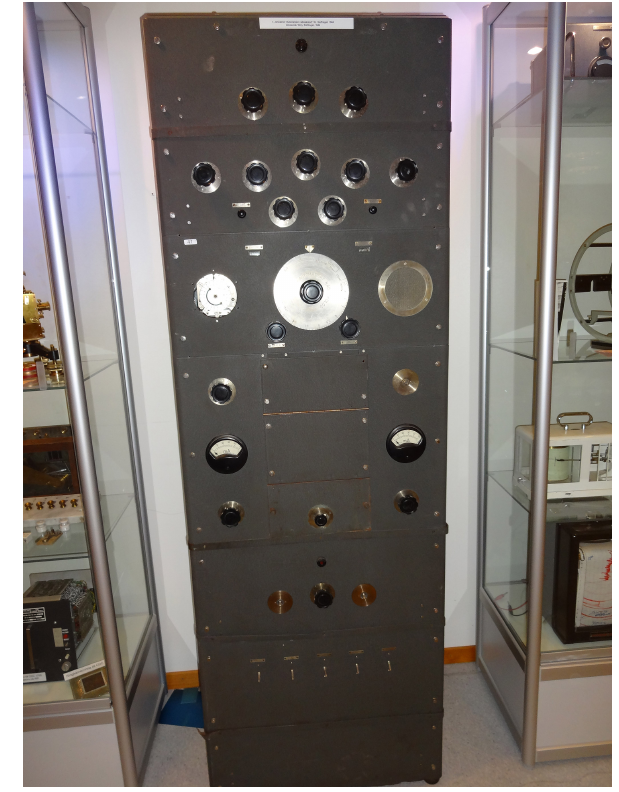
Figure 4. Ionosonde developed by Stoffregen.